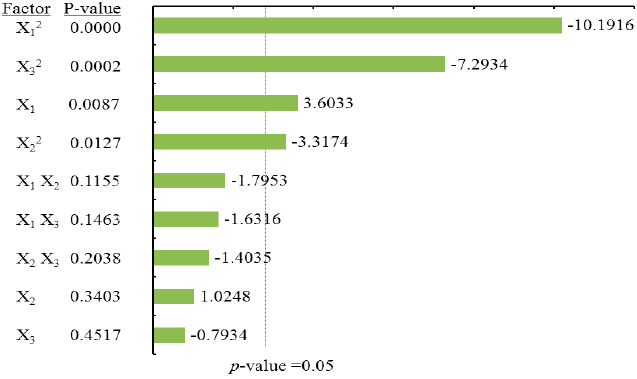
Figure 3. Pareto chart of the effects for the total flavonoids yield. Standardized effect estimate (absolute value).